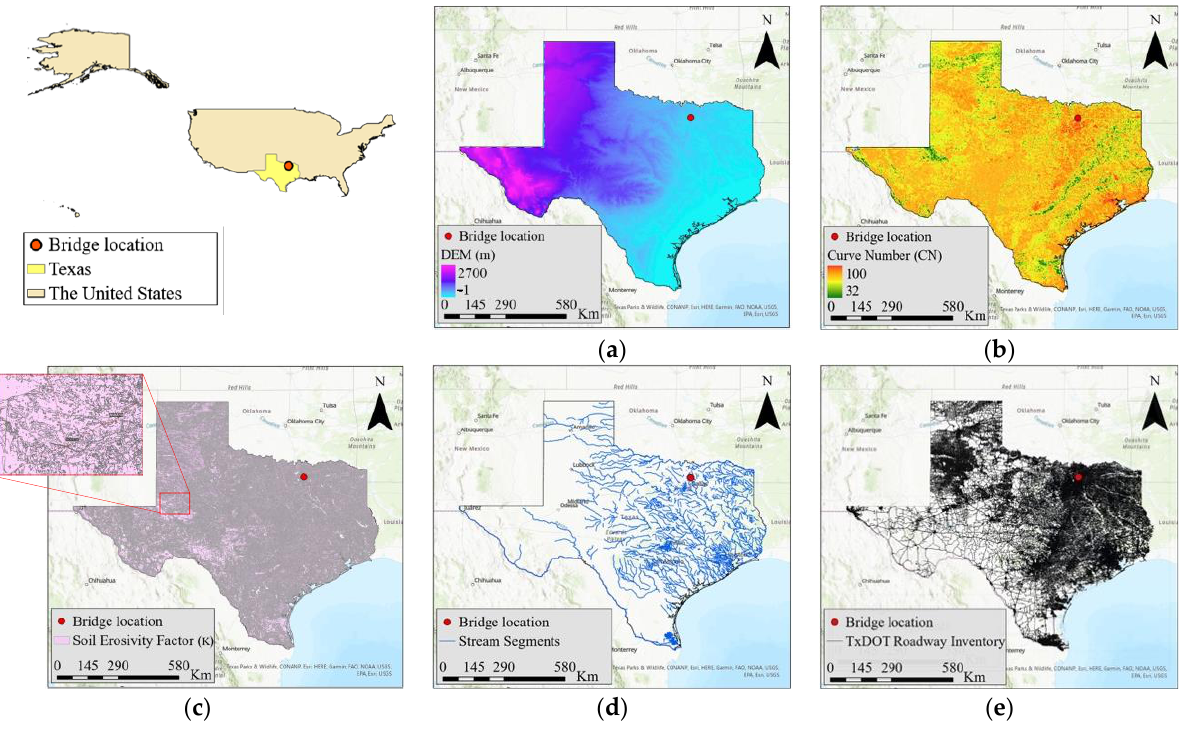
Figure 2. Pre-populated base data in the GIS toolkit for the state of Texas: ( a ) Digital elevation model (DEM), ( b ) Curve Number ( CN ), ( c ) Soil erosivity factor ( K ), ( d ) Stream segments, and ( e ) Road inventory map